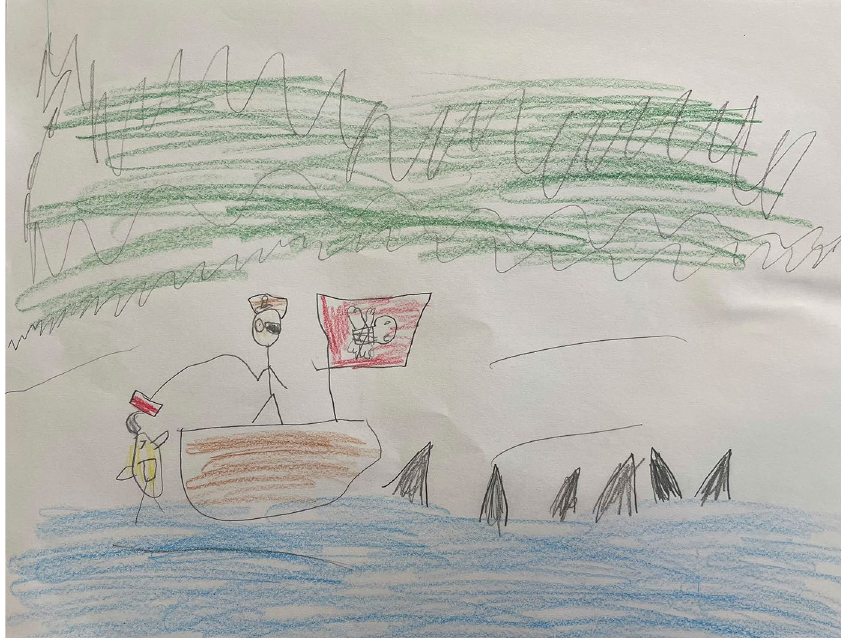
Fig. 1 CTE Drawing of a pri- mary school